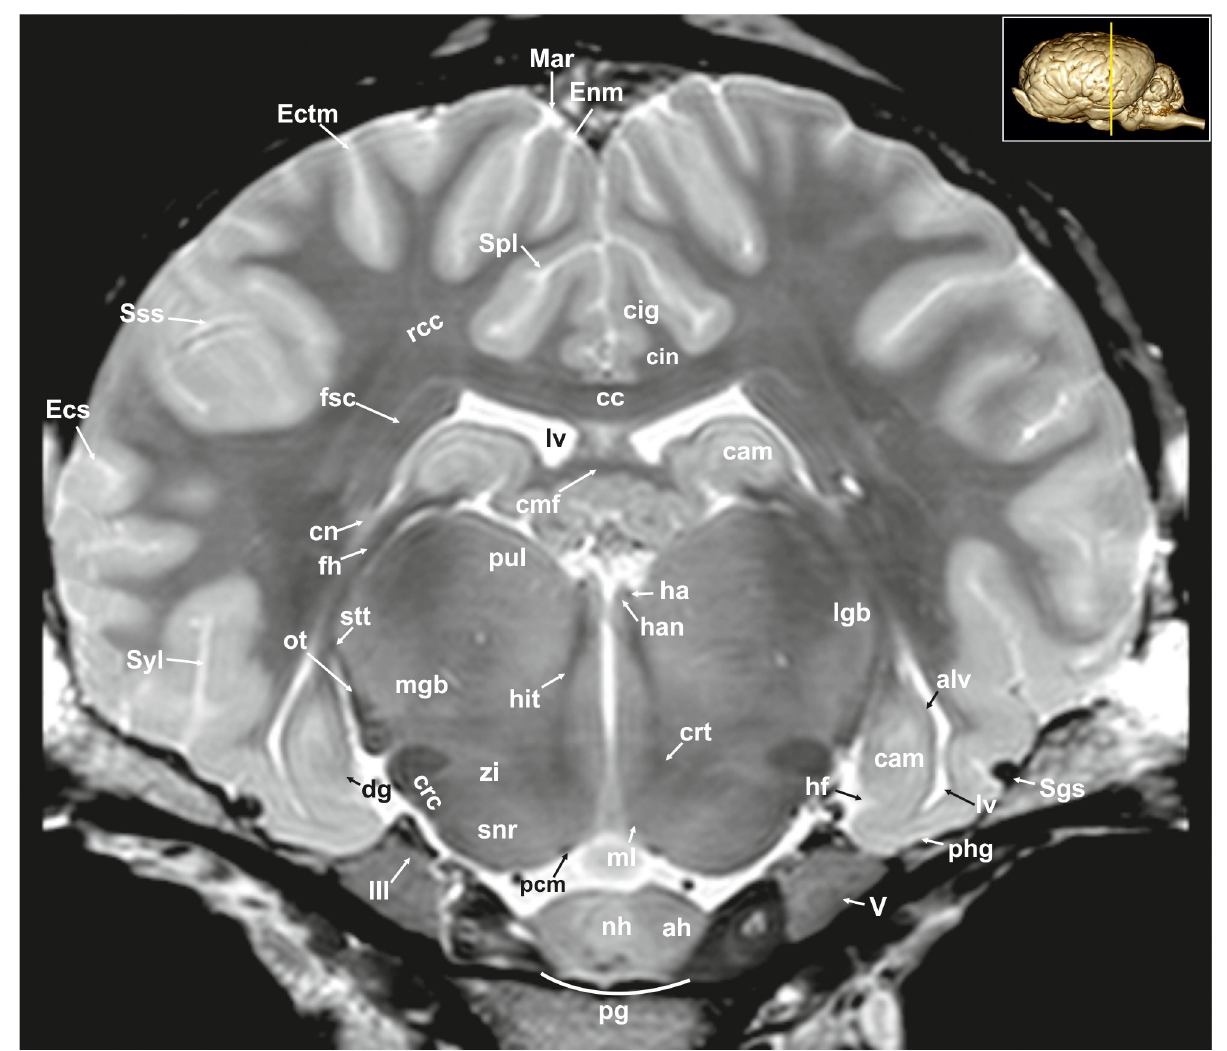
Fig 8. Transverse magnetic resonance image of the equine on the level of the hippocampus. ah: adenohypophysis, alv: alveus, cam: ammon’s horn, cc: corpus callosum, cin: cingulum, cmf: commissure of fornix, cn: caudate nucleus, crc: cerebral crus, crt: rubro-cerebello-thalamic tract, dg: dentate gyrus, Ecs: ectosylvian sulcus, Ectm: ectomarginal sulcus, Enm: endomarginal sulcus, fh: fimbria of the hippocampus, fsc: subcallosal fasciculus, ha: habenula, han: habenular nuclei, hf: hippocampal fissure, hit: habenulo-interpeduncular tract, lgb: lateral geniculate body, lv: lateral ventricle, Mar: marginal sulcus, max: maxillary nerve, mgb: medial geniculate body, ml: medial lemniscus, nh: neurohypophysis, ot: optic tract, pcm: peduncles of the mammillary body, phg: parahippocampal gyrus, pul: pulvinar nuclei, rcc: radiation of corpus callosum, Sgs: sagittal sulcus, snr: substantia nigra, Sss: suprasylvian sulcus, stt: terminal stria; Syl: sylvian fissure, zi: zona incerta, III: oculomotor nerve.